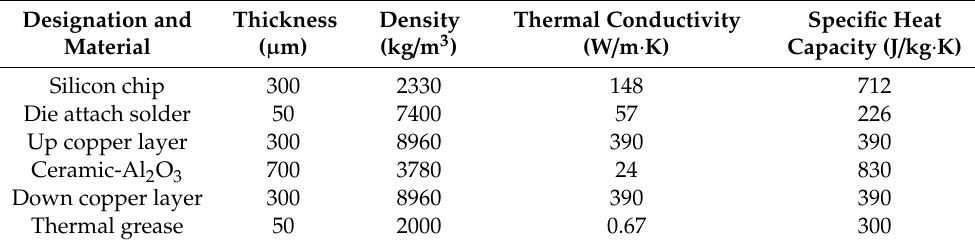
Table 1. Layer thickness and material properties of IGBT in simulation.